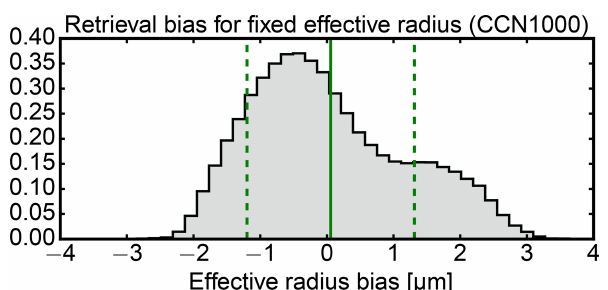
Figure 23. Retrieval deviations (retrieved r eff , retr – apparent r eff ) for the nine cloud sides with fixed effective radius profiles which are not included in the ensemble. The solid green line shows the average bias in retrieved effective radius r eff , retr , the dashed green lines show the RMSE for r eff , retr